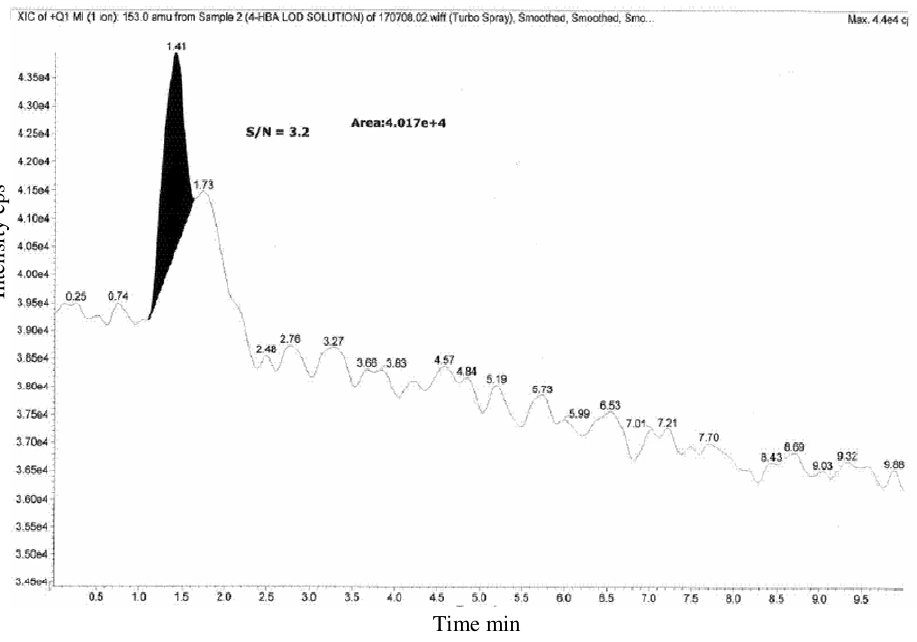
Figure 1. LOD chromatogram of